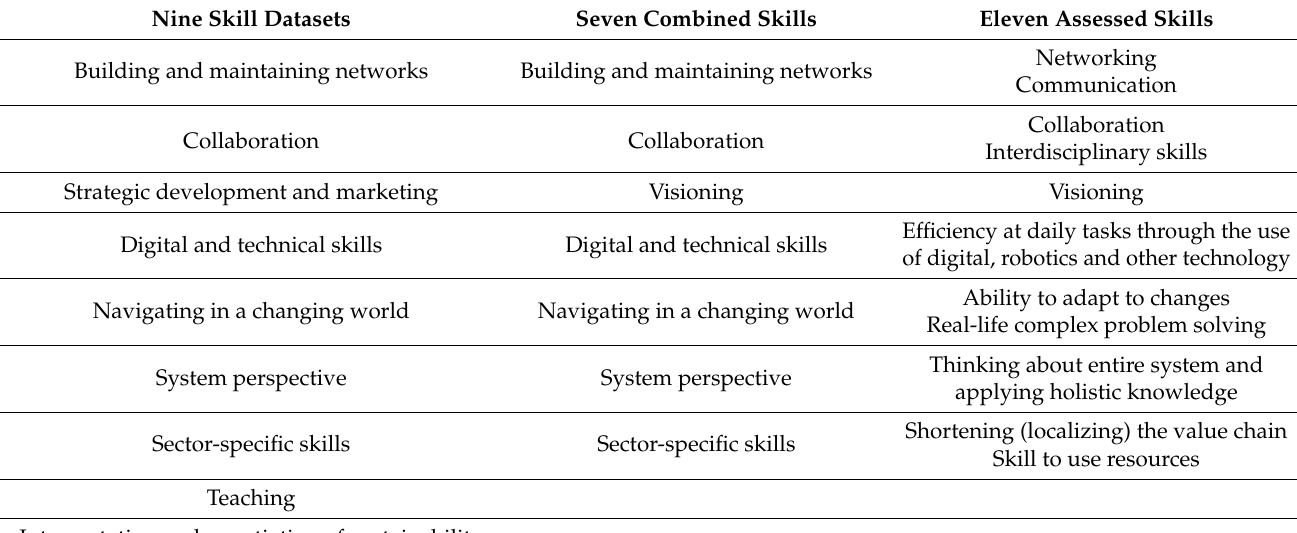
Table 2. Comparison of skills used for quantitative and qualitative